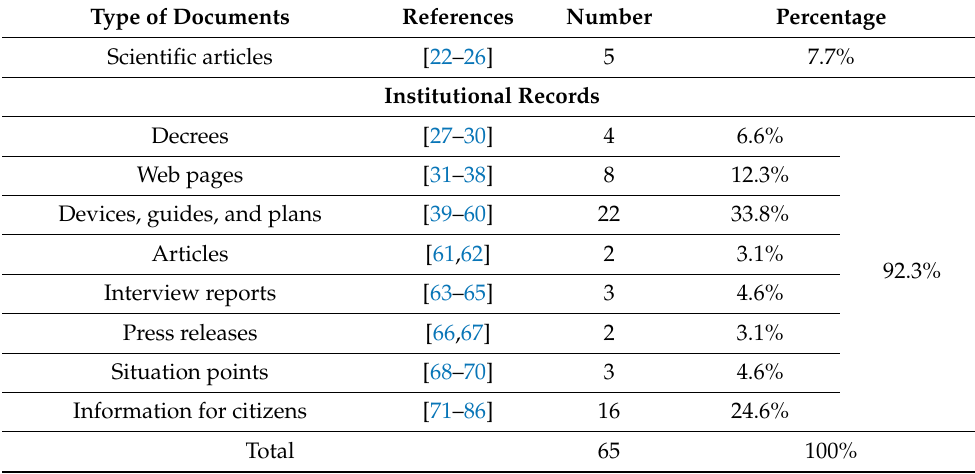
Table 2. Types of documents included in the study.